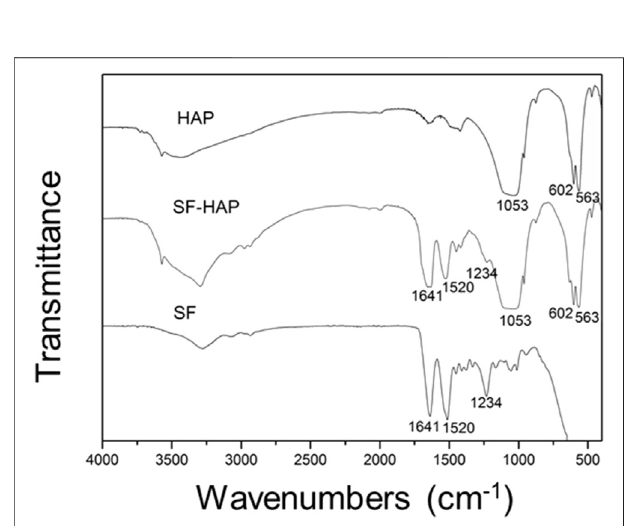
FIGURE 5 | FT-IR spectra of HAP, SF, and SF/nHAp